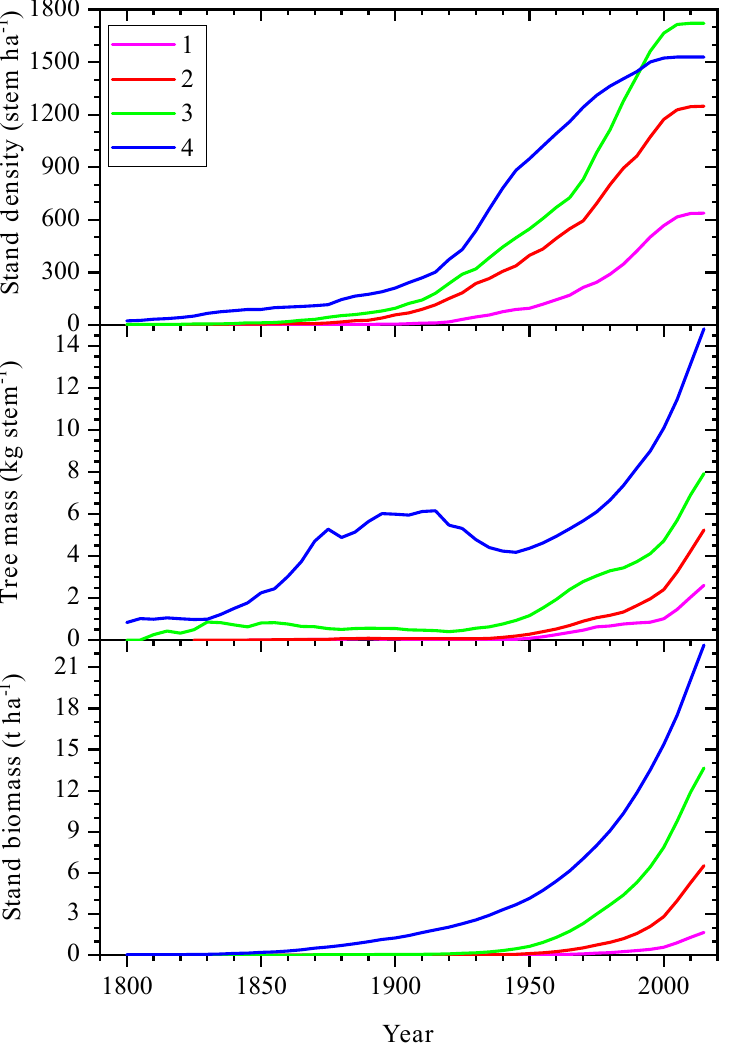
Figure 5. Changes of average tree mass, stand density, and biomass since the year 1800 on different levels of the forest–tundra transition on the slopes of the Khibiny massif (Kola Peninsula) with mountain birch and Siberian spruce dominating (on the low parts): 1—sparse tree stand line; 2—open forest line; 3—present-time closed forest line; and 4—historical (in 1950–1960s) closed forest line.